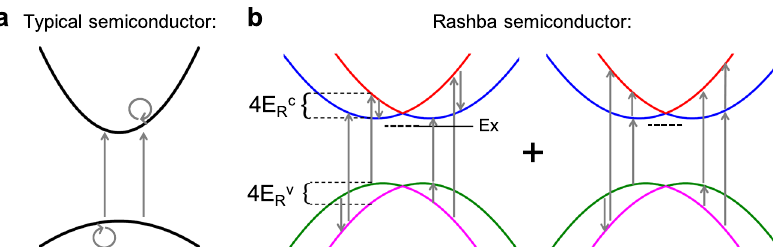
Fig. 1 Schematic illustration of the two-photon pathways for semiconductors with and without Rashba splitting. a Two-photon pathways for transitions between initial, intermediate, and fi nal states limited to highest valence and lowest conduction bands in a typical semiconductor. b Examples of additional two-photon pathways for transitions between initial, intermediate, and fi nal states available in a semiconductor that exhibits Rashba splitting. The energy of the Rashba splitting in the conduction band ( E Rc ) and valence band ( E Rv ), as well as the exciton (Ex),